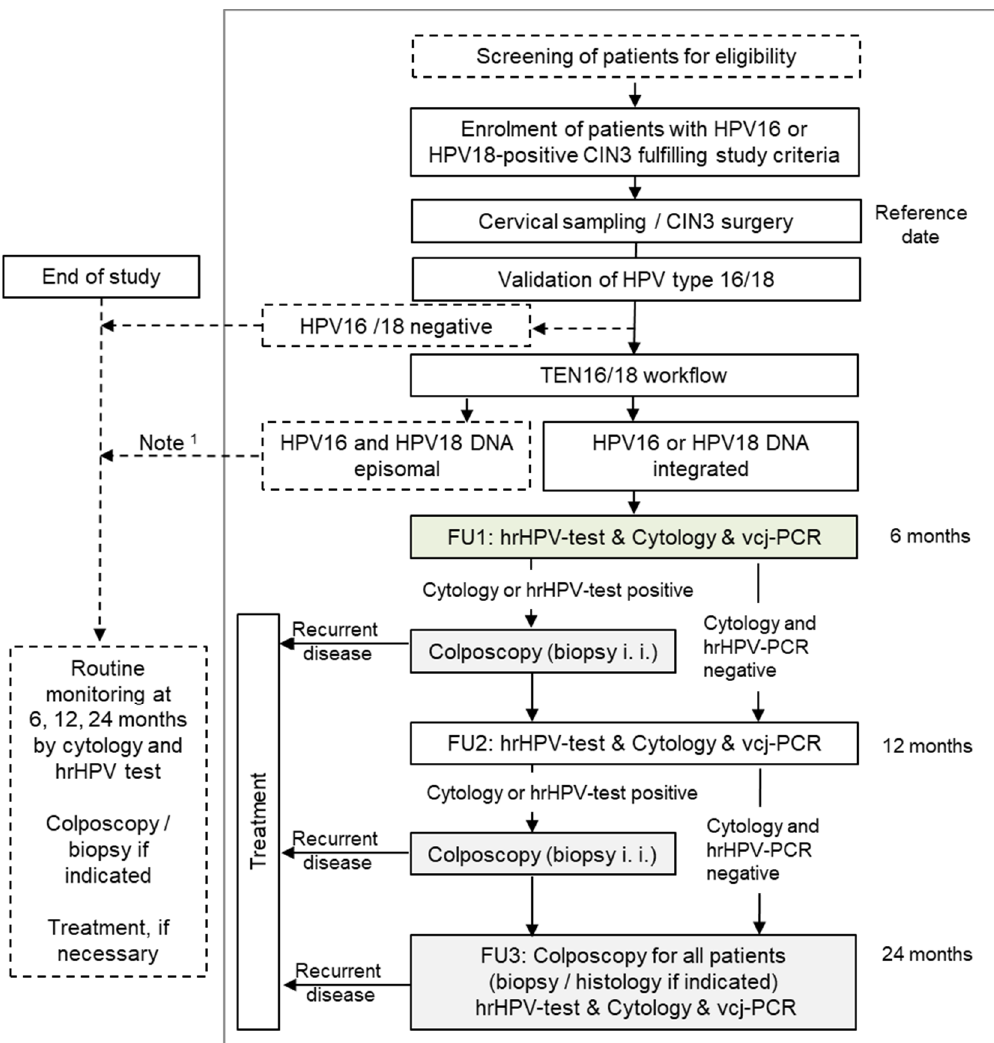
Figure 1. Flow chart of study procedures according to the study protocol. HPV—human papilloma virus; CIN3—cervical intraepithelial neoplasia Grade 3; TEN—target enrichment and next generation sequencing; FU—follow-up visit; hrHPV—high risk HPV; vcj-PCR—viral cellular junction polymerase chain reaction; i. i.—if indicated; 1 end of study was intended for patients without evidence of HPV16/18 integration. Because the TEN16/18 analyses required more time than initially anticipated, a subset of patients without evidence of HPV-DNA integration were followed further by standard